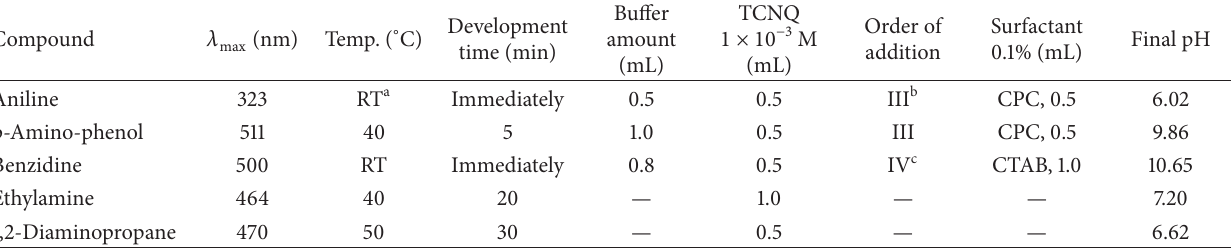
Table 3: Optimum conditions for the determination of primary amines with TCNQ reagent.